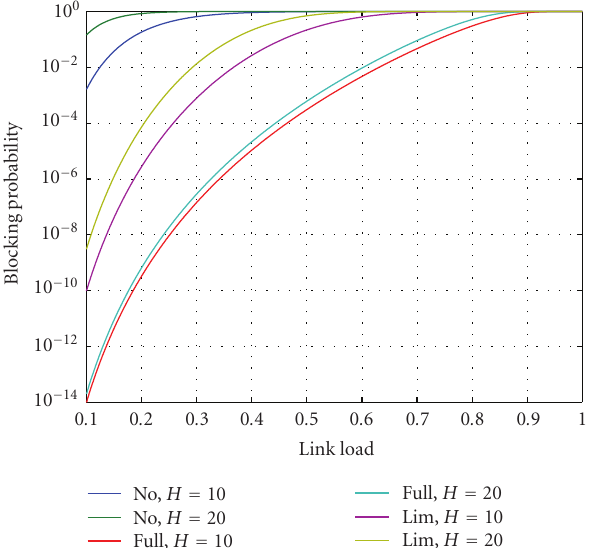
Figure 2: The blocking probability P b = f ( ρ ), W = 15, k = 3, and F = 1.